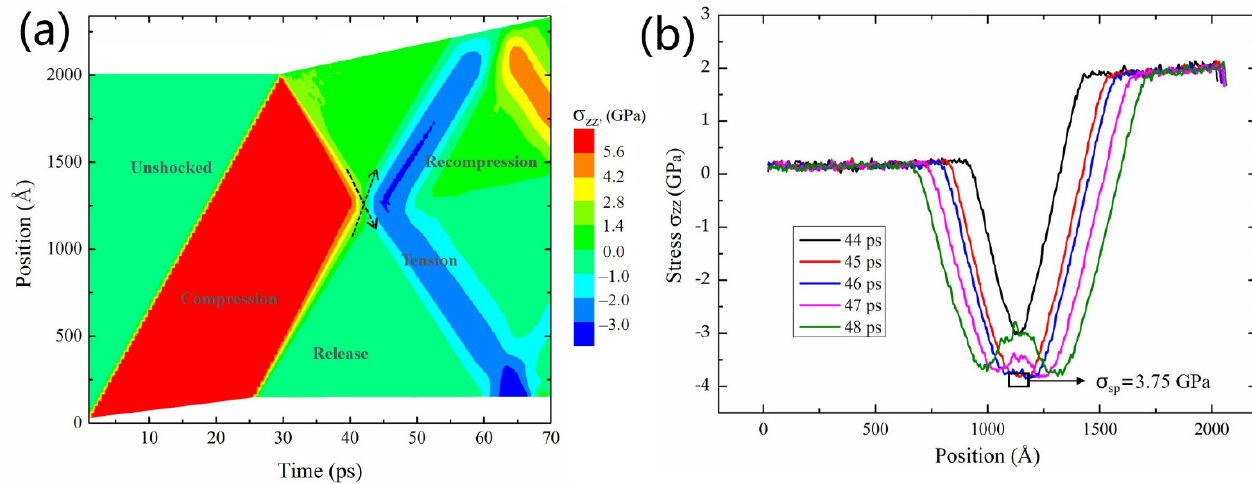
Figure 1. ( a ) Contour plot of evolution of stress ( σ zz ) as a function of time along the [0001] direction with C v = 2.0% under V p = 0.5 km/s. The colors are colored by local stress, a positive value corresponds to compressive stress, and a negative value corresponds to tensile stress. ( b ) The corresponding spatial distributions of stress ( σ zz ) before and after nucleation of spall damage.